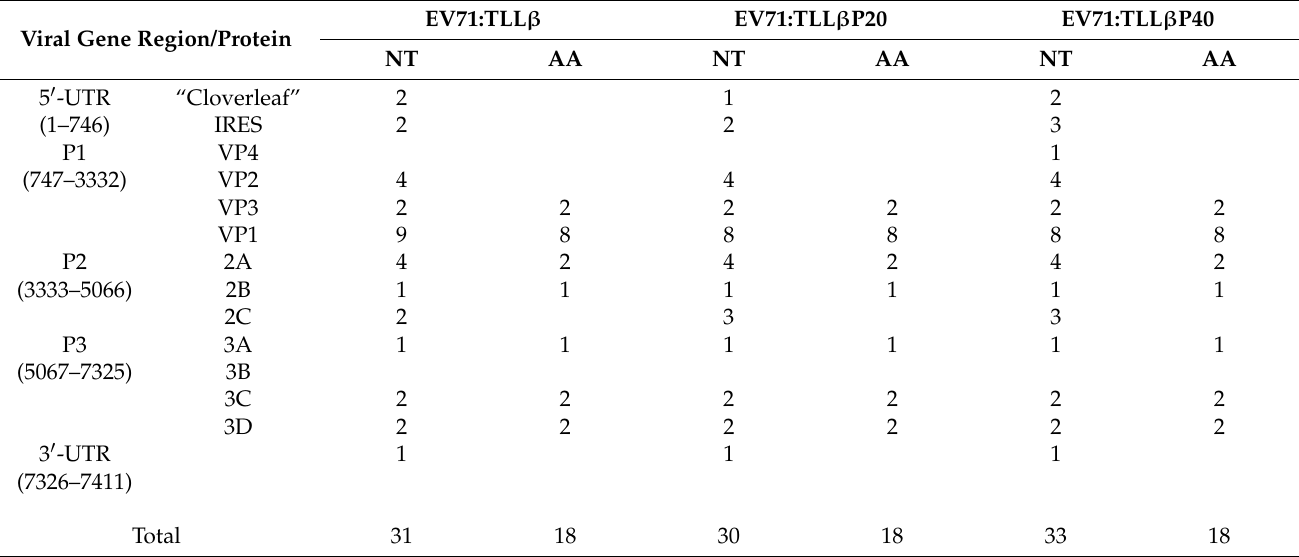
Table 2. The number of nucleotide (NT), and corresponding amino acid (AA), mutations that occurred in each of the genomic segments of EV71:TLL β , EV71:TLL β P20 and EV71:TLL β P40 compared with their original parental wild-type. Viral Gene